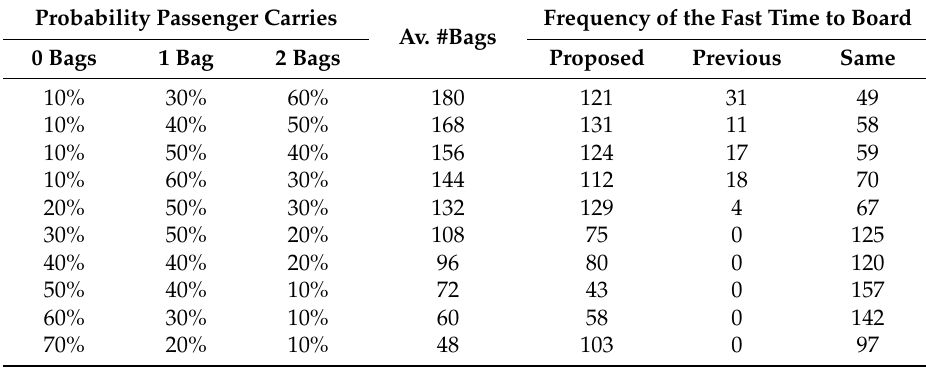
Table 6. Frequency of the proposed method doing better, worse or the same as the previous method in scenario